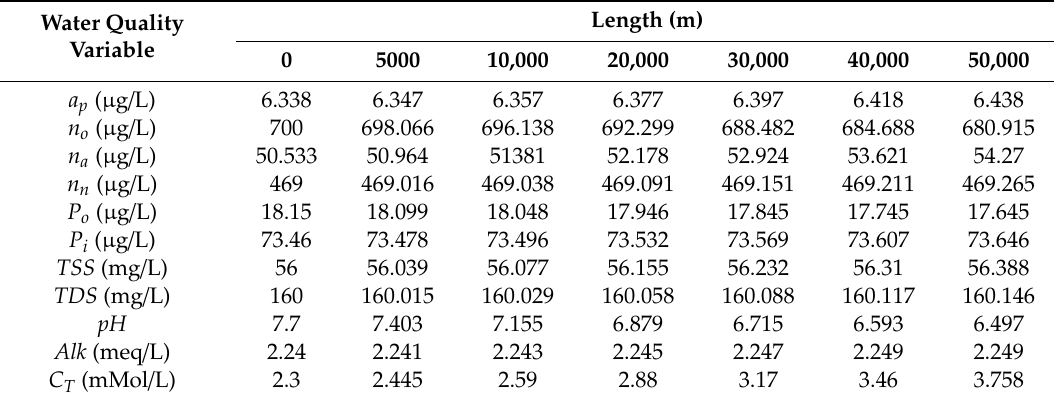
Table 9. Main canal simulation